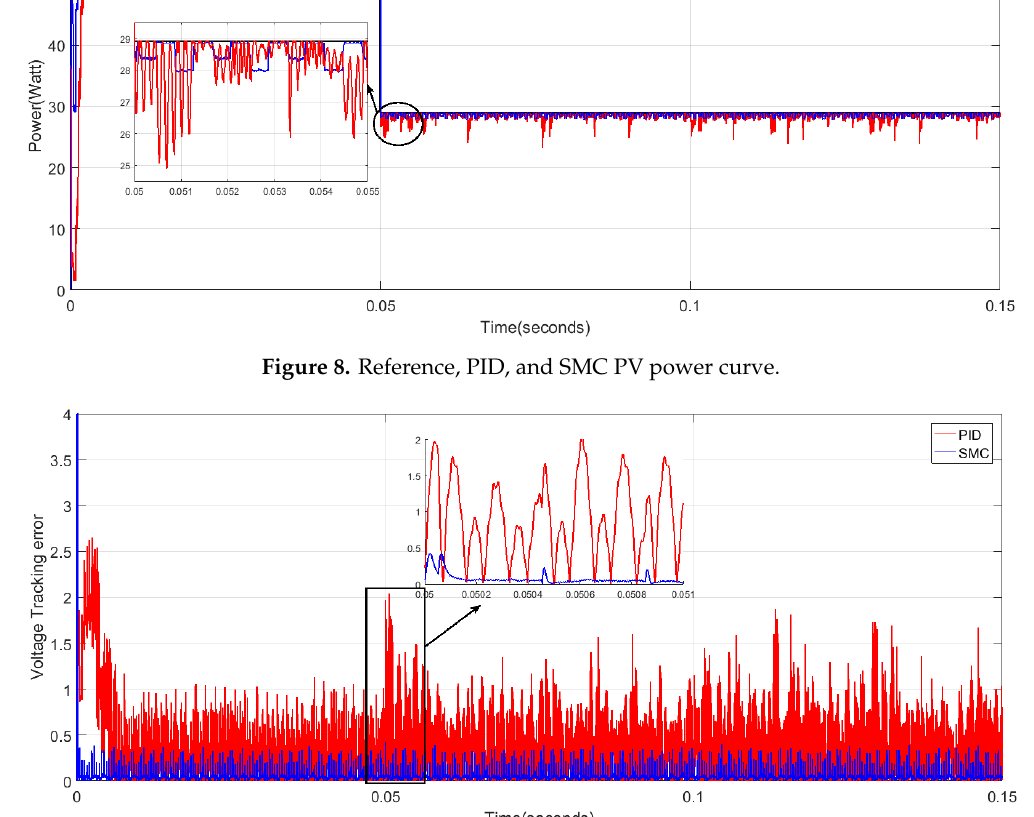
Figure 9. PID and SMC PV tracking error curve.